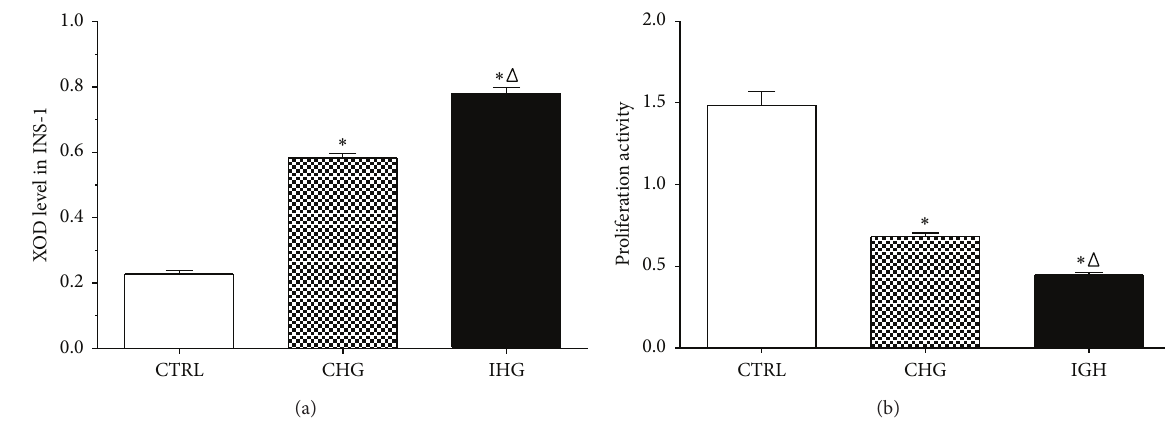
Figure 3: The intracellular XOD activity and cell viability in INS-1 cells. XOD activity was measured spectrophotometrically using Xanthine Oxidase Activity Colorimetric/Fluorometric Assay Kit (a). The cell viability in INS-1 cells was measured by Cell Counting Kit-8 assay (b). Control, normal glucose; CHG, constant high glucose; IHG, intermittent high glucose. Each bar represents the mean ± S . D. ∗ 𝑃 < 0.05 and Δ 𝑃 < 0.05 , respectively, indicate a significant difference from controls and